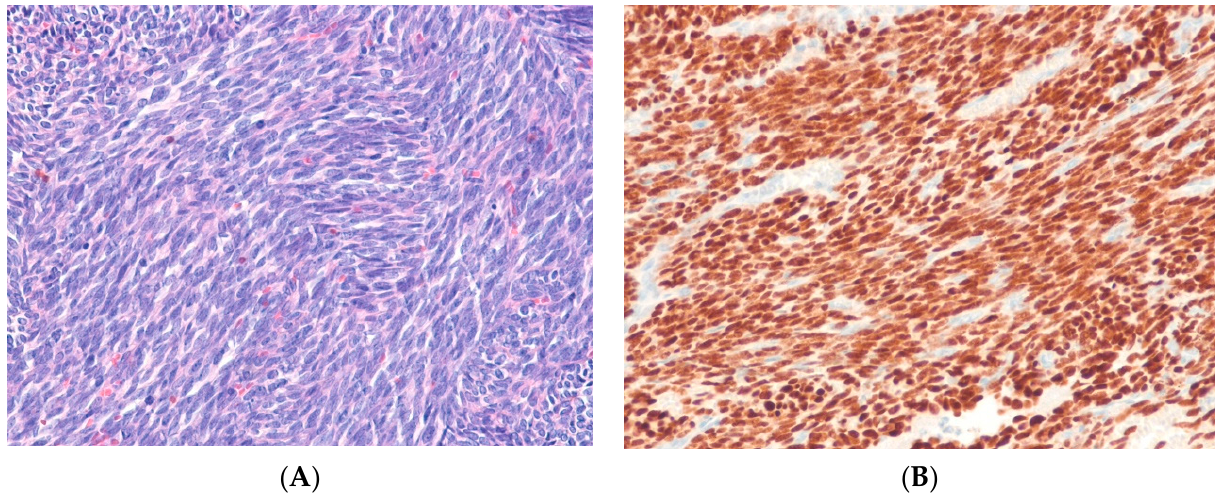
Figure 7. Monophasic synovial sarcoma. ( A ) The tumor shows fascicles of monomorphic spindle cells (H&E stain, × 100). ( B ) The tumor cells show strong nuclear expression for SS18-SSX antibody, consistent with the presence of an underlying SS18 :: SSX fusion gene (immunohistochemical stain for SS18-SSX antibody, ×200).